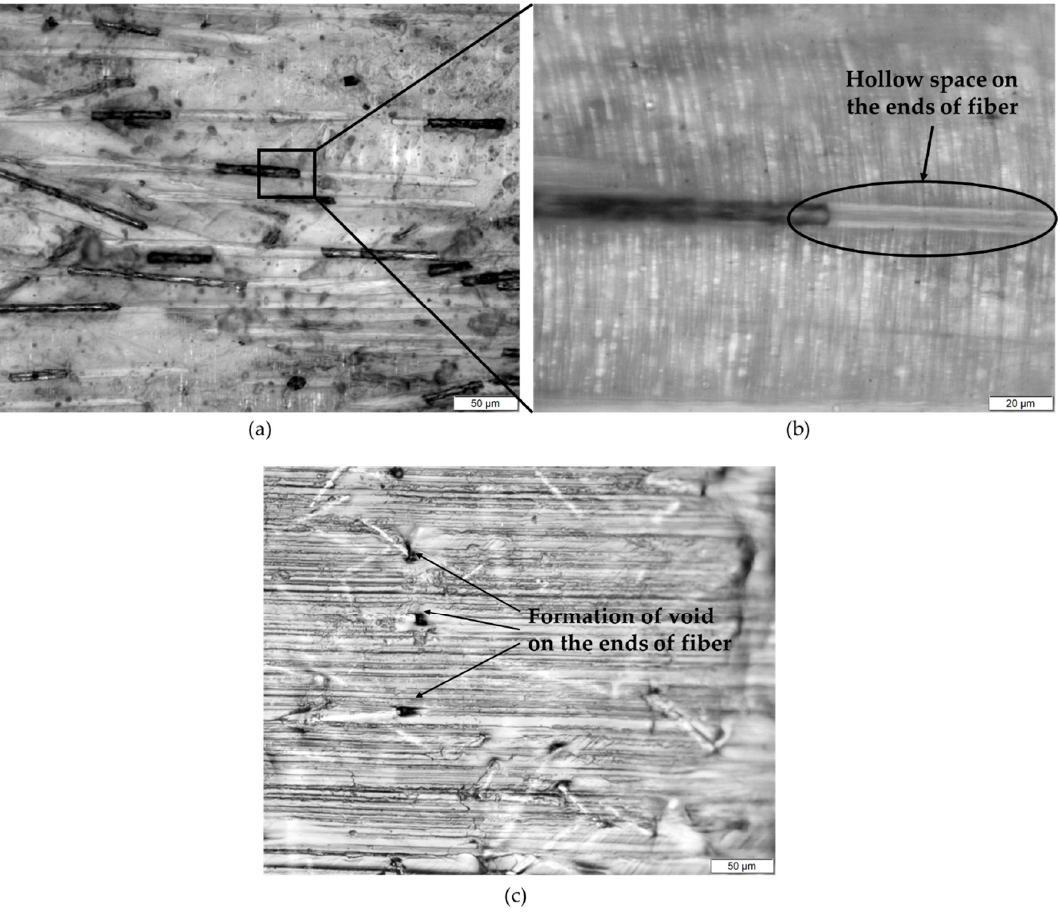
Figure 5. Optical microscope images of ( a ) PP / 5SCF, ( b ) image in panel ( a ) at higher magnification, and ( c ) PP / 10SCF composite after tensile test.